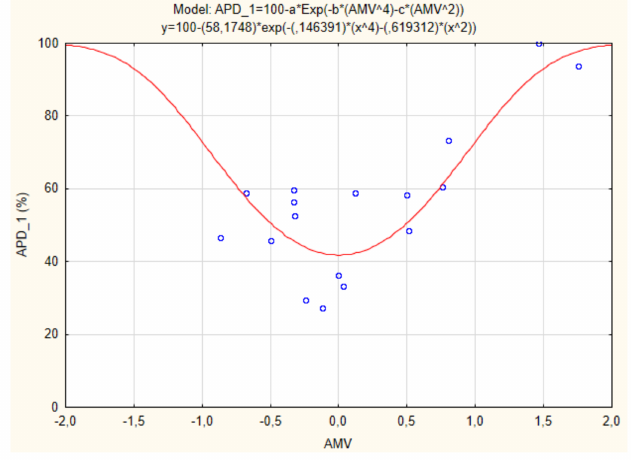
Figure 6. APD_1. The curve generated in Figure 6 is expressed by Equation (3):